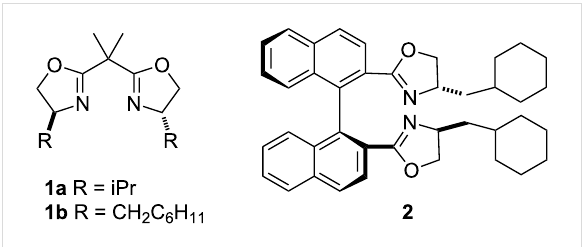
Figure 3: Chiral bis(oxazoline) ligands used in enantioselective copper carbenoid